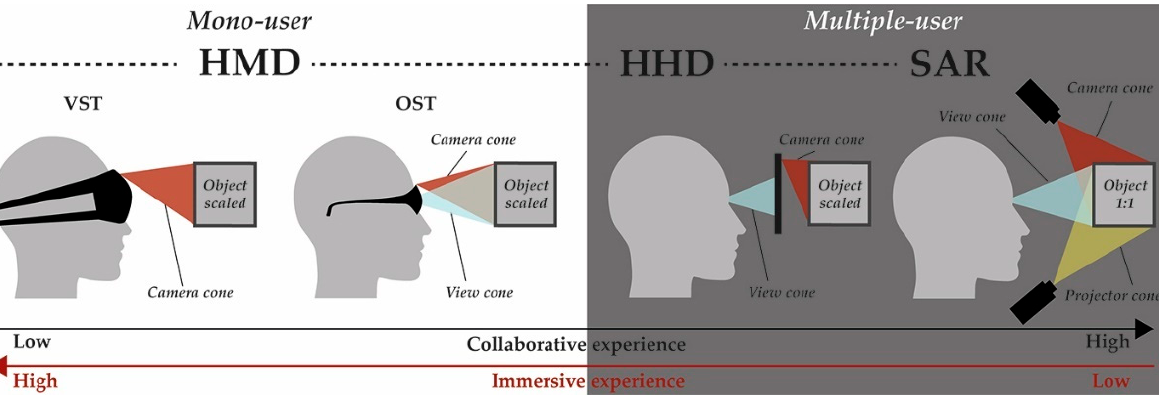
Figure 11. Functional schema of the different AR displays.